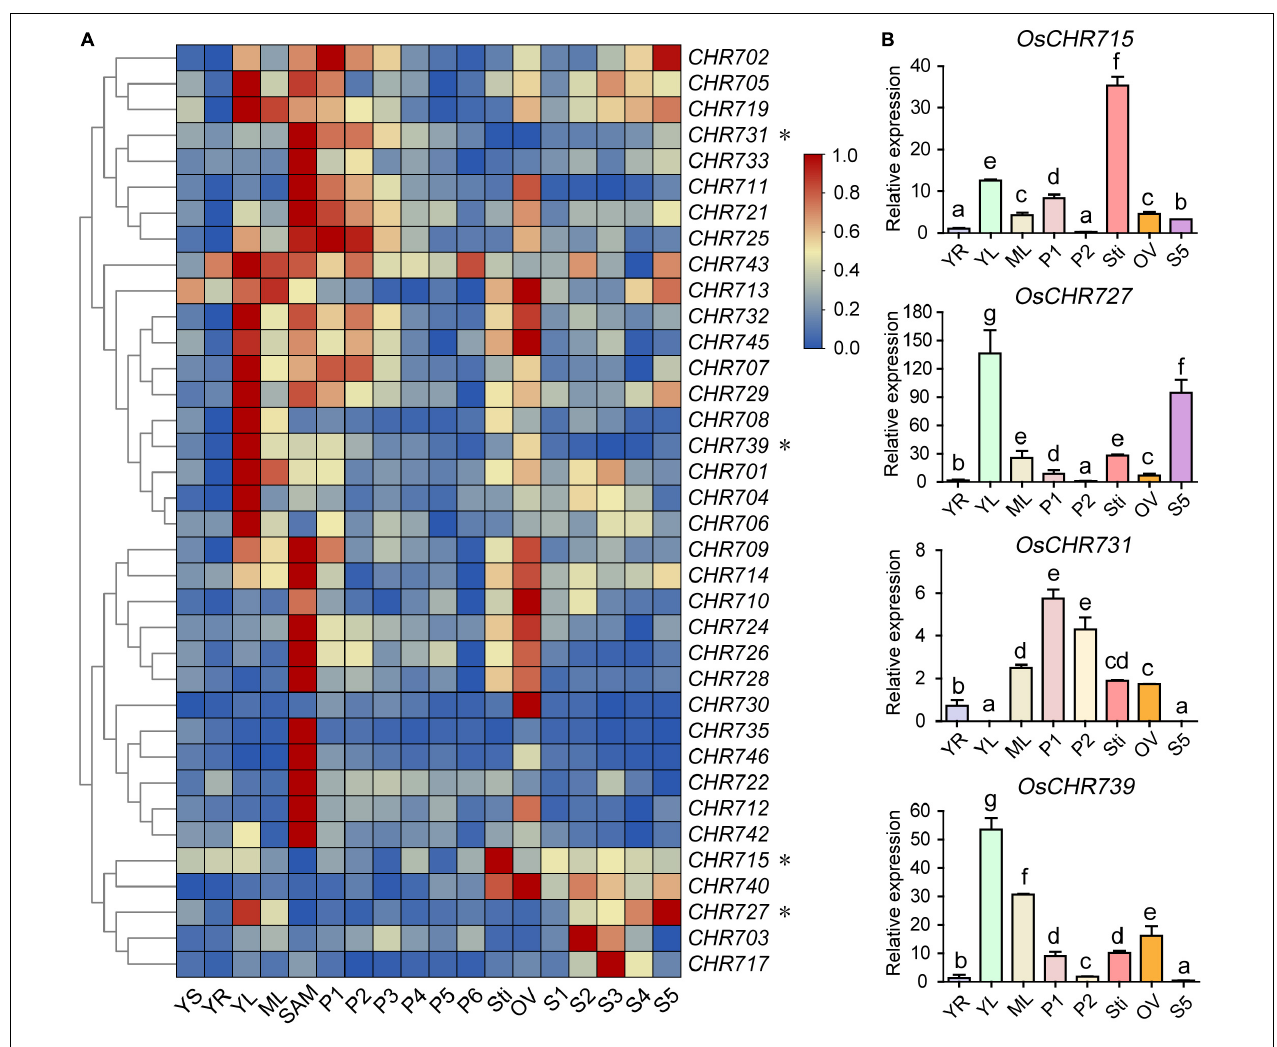
FIGURE 1 | Expression profiles of Snf2 genes in various organs. (A) The microarray data (GSE6893, GSE6901, and GSE7951) of Snf2 genes’ expression in various organs at different developmental stages were reanalyzed. A heat map representing hierarchical clustering of average log2 expression values of Snf2 genes in various organs are generated (YS, 7-day-old seedlings; YR, roots from 7-day-old seedlings; YL, leaves from 7-day-old seedlings; ML, mature leaf; SAM, shoot apical meristem; different stages of panicle development: P1, 0–3 cm; P2, 3–5 cm; P3, 5–10 cm; P4, 10–15 cm; P5, 15–22 cm; P6, 22–30 cm; Sti, stigma of mature ovaries; OV, mature ovary; different stages of seed development: S1, 0–2 dap (day after pollination); S2, 3–4 dap; S3, 5–10 dap; S4, 11–20 dap; S5, 21–29 dap). The representative Snf2 genes are differentially expressed in various organs, for which real-time PCR analysis was performed, indicated by an asterisk ( ∗ ) on the right. The color scale (representing average log signal values) is shown on the right side. (B) The representative Snf2 genes (asterisks indicate genes in A ) are differentially expressed in various organs consistent with the samples of microarray using the qRT-PCR. Error bars indicate standard deviations of independent biological replicates ( n = 3). Different letters denote significant differences at P < 0.05 according to ANOVA in combination with Duncan’s multiple range test.